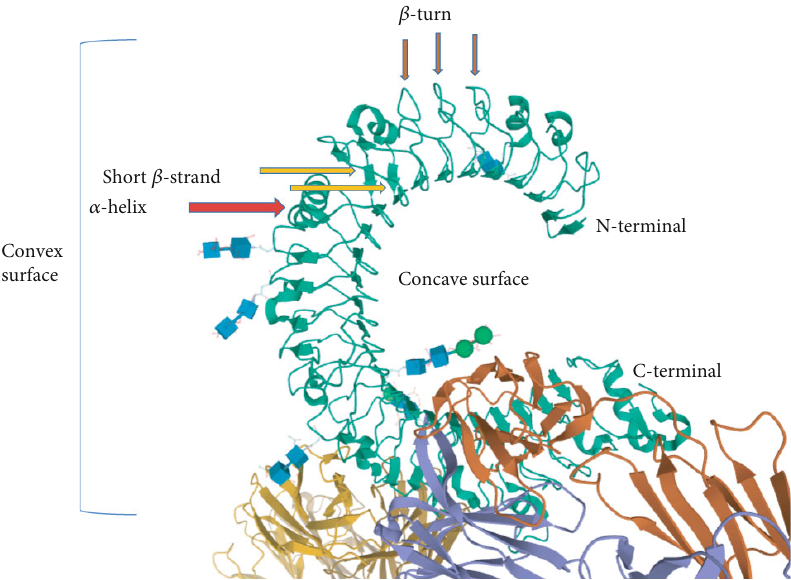
Figure 2: The horseshoe-like structure of LRR belonging to TLR3 ectodomain. The solenoid con fi guration of the LRR domain in TLR3 (3ULU PDB fi le)